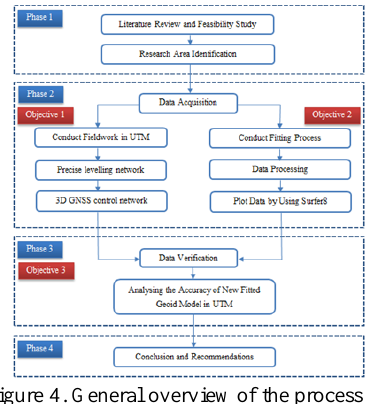
Figure 4. General overview of the